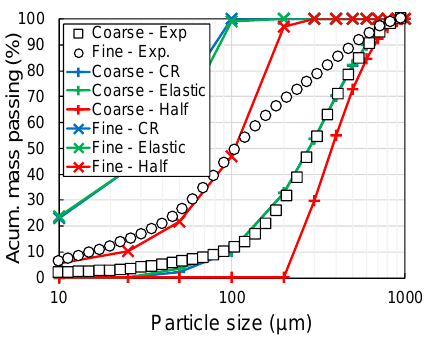
Fig. 9. PSD of products for the 15  inclined cases and 1.5 m/s varying the